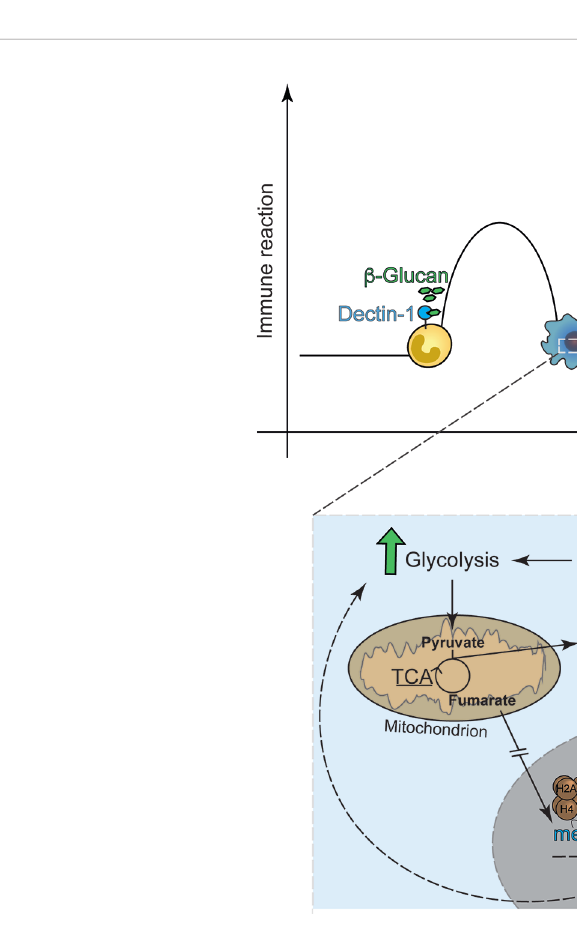
FIGURE 1 | Classical in vitro model of trained immunity. Trained immunity describes a functional, metabolic and epigenetic adaptation of innate immune cells to previous stimuli with ensuing increased immune response, i.e. cytokine release, to secondary stimulation. (A) The classical model applies the Dectin-1 agonist b -1,3- D Glucan as the fi rst stimulus and the TLR-4 agonist LPS as the second stimulus. (B) The basis for b -1,3-D Glucan induced trained immunity are metabolic adaptations, including the mTOR signal-transduction enhanced glycolysis. Interrupted errors indicate that many more proteins are involved in the signaling cascade, which are not depicted in the fi